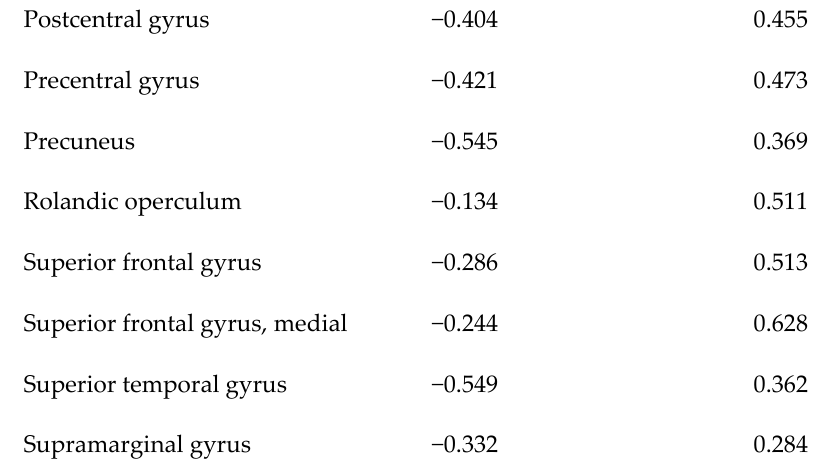
Figure 4. Correlation between A β burden and IFC in CEN.